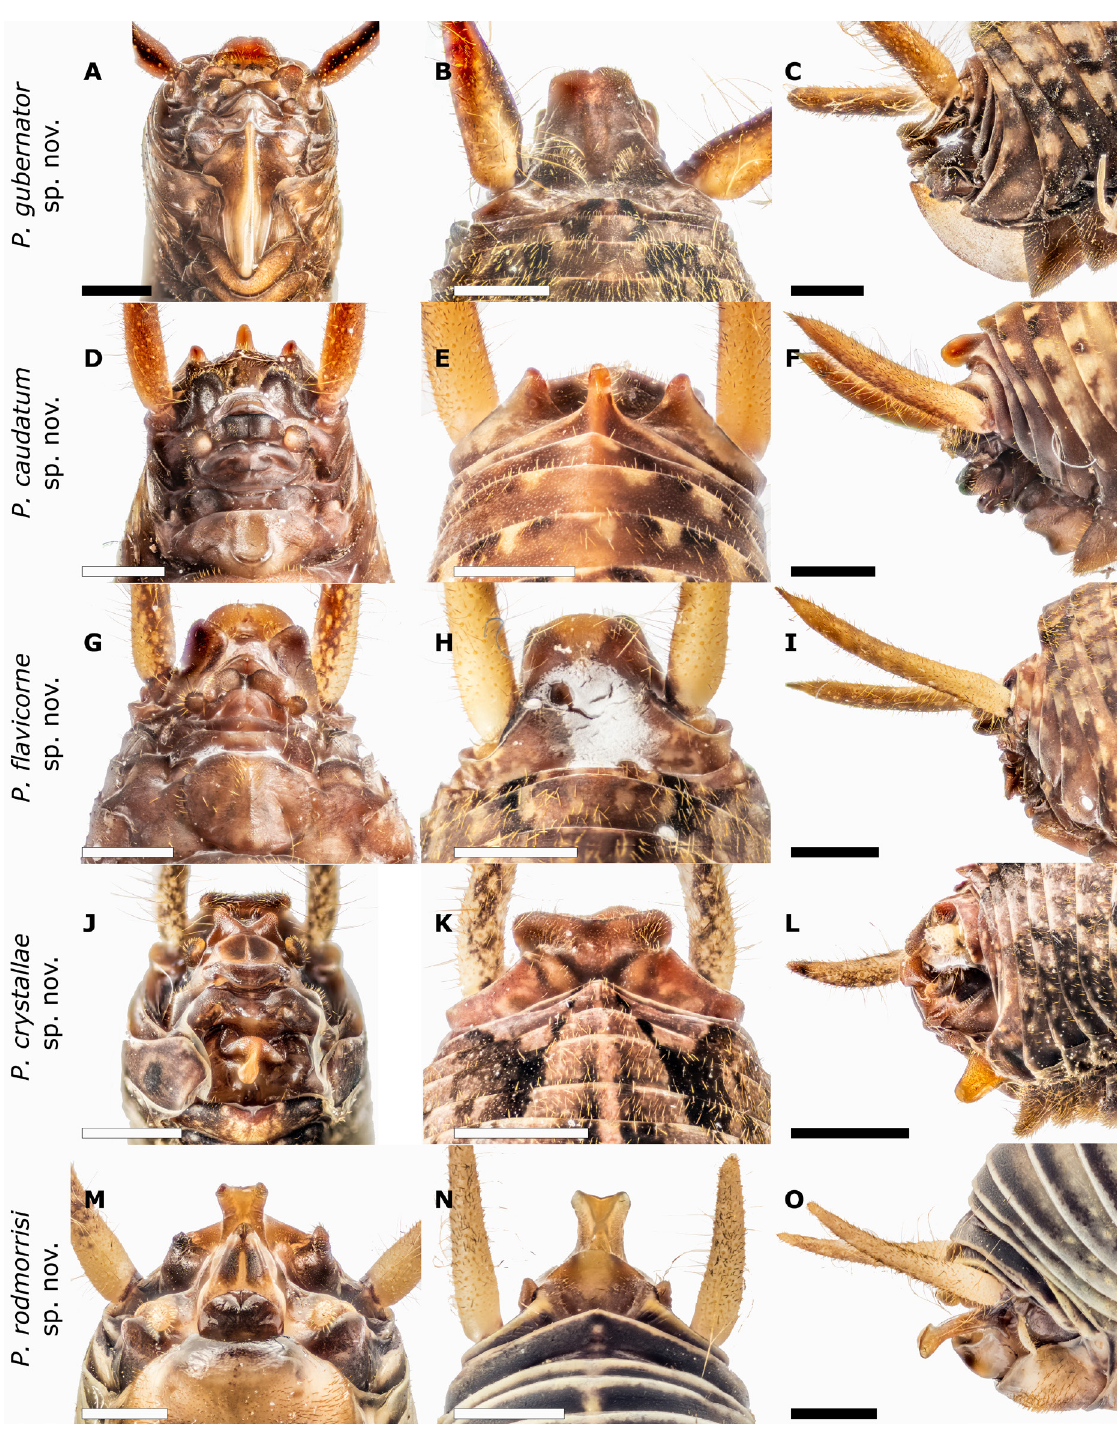
Fig. 9. Adult male terminalia of cave wētā in the genus Pleioplectron Hutton, 1896. Left column: ventral view (subgenital plate); central column: dorsal view; right column: lateral view. A–C . P.